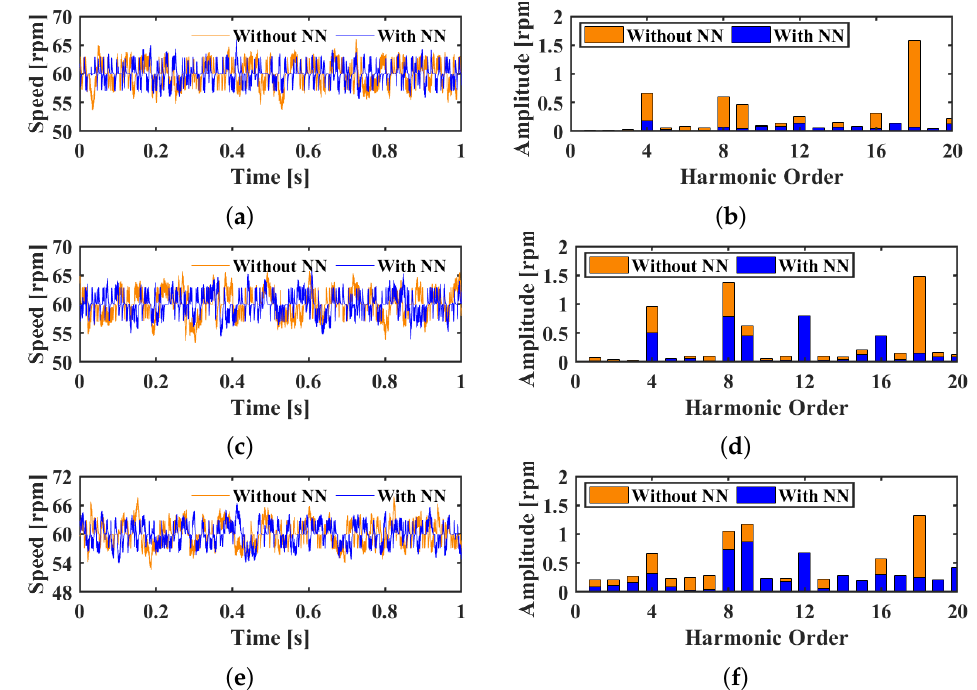
Figure 12. Speed ripple in conventional ESO-ADRC system and modified NN-ESO-ADRC system at the speed of 60 rpm. ( a ) 0.1 Nm load torque, ( b ) spectrum analysis with 0.1 Nm load torque, ( c ) 1.1 Nm load torque, ( d ) spectrum analysis with 1.1 Nm load torque, ( e ) 2.2 Nm load torque, and ( f ) spectrum analysis with 2.2 Nm load